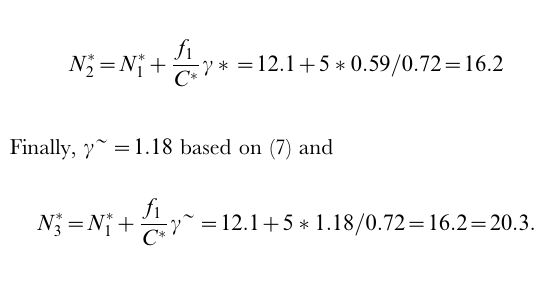
Table 3: Germany ( n =1314; [20,21]), Iceland ( n = 396; [22]),